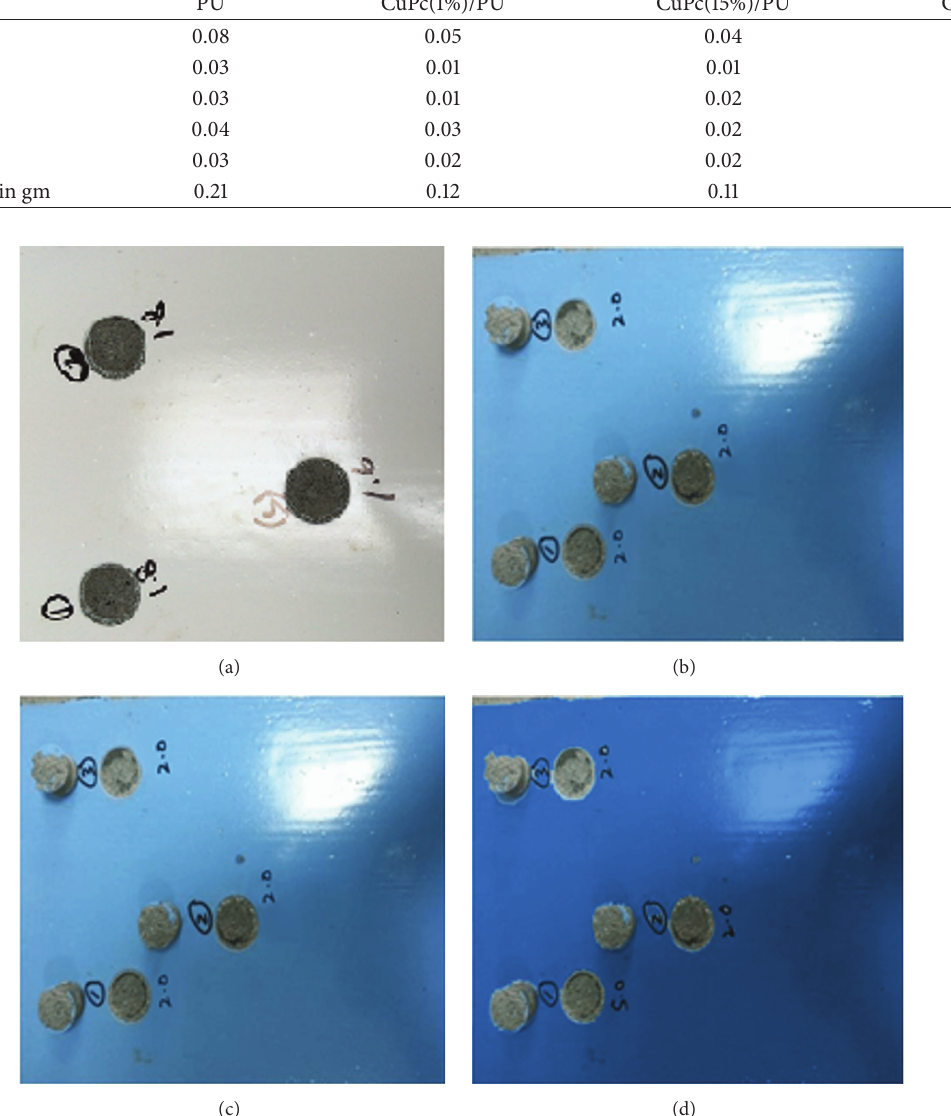
Figure 3: Adhesion test of PU (a), CuPc(1%)/PU (b), CuPc(15%)/PU (c), and CuPc(30%)/PU (d),